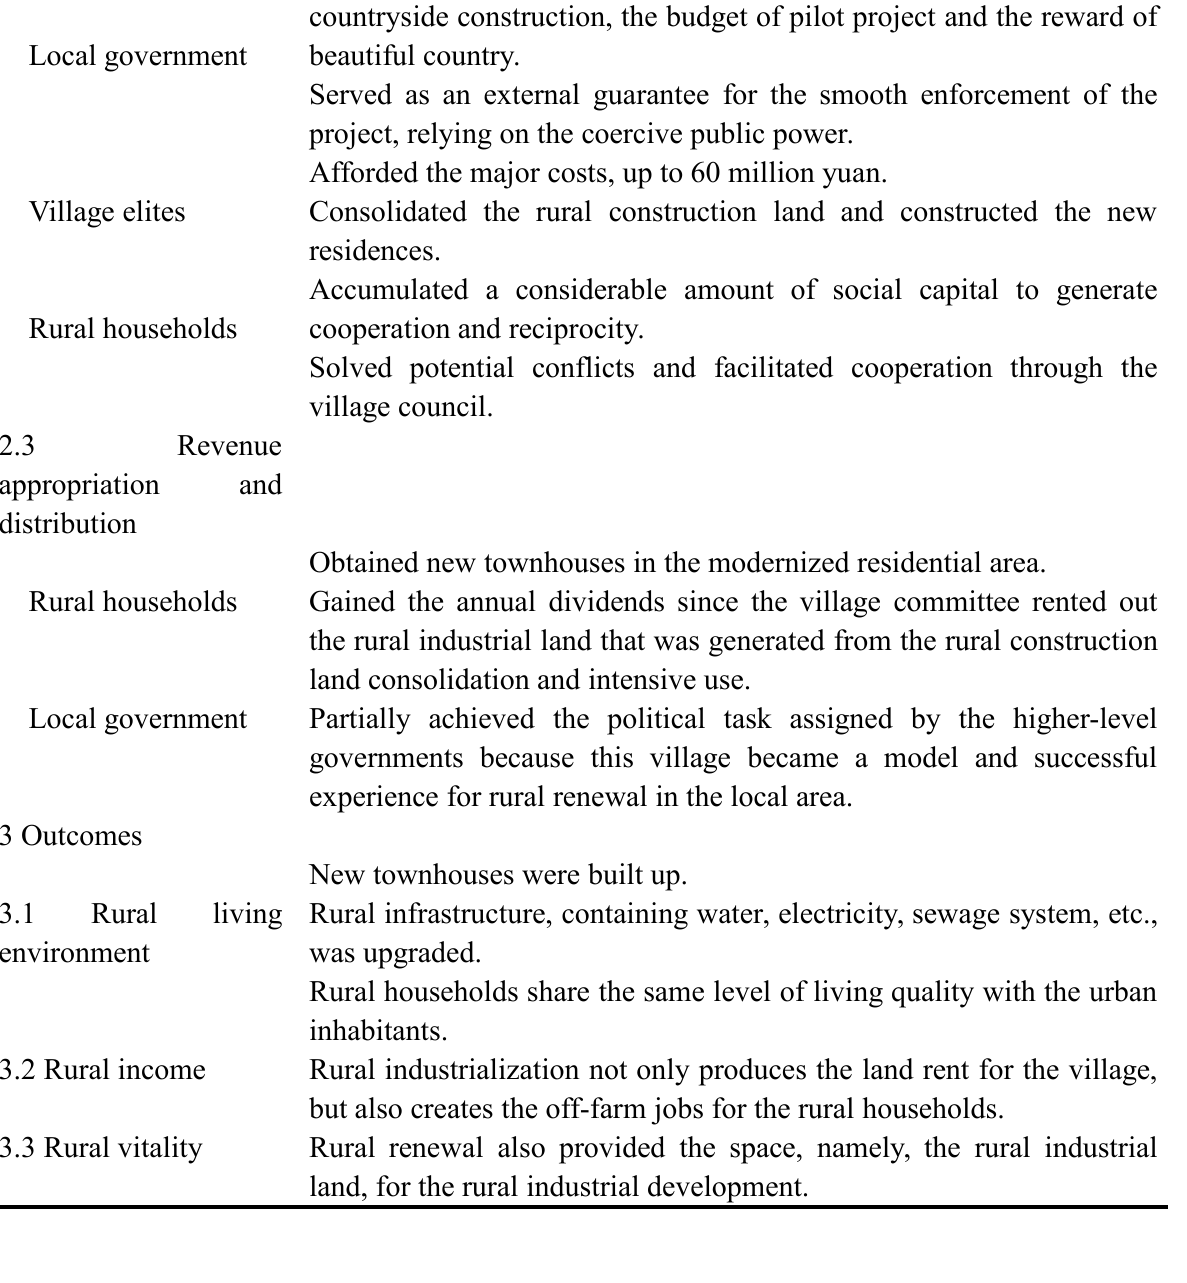
Table A3.8: Archetype 8 Self-organized small-scale rural renewal with a long-term